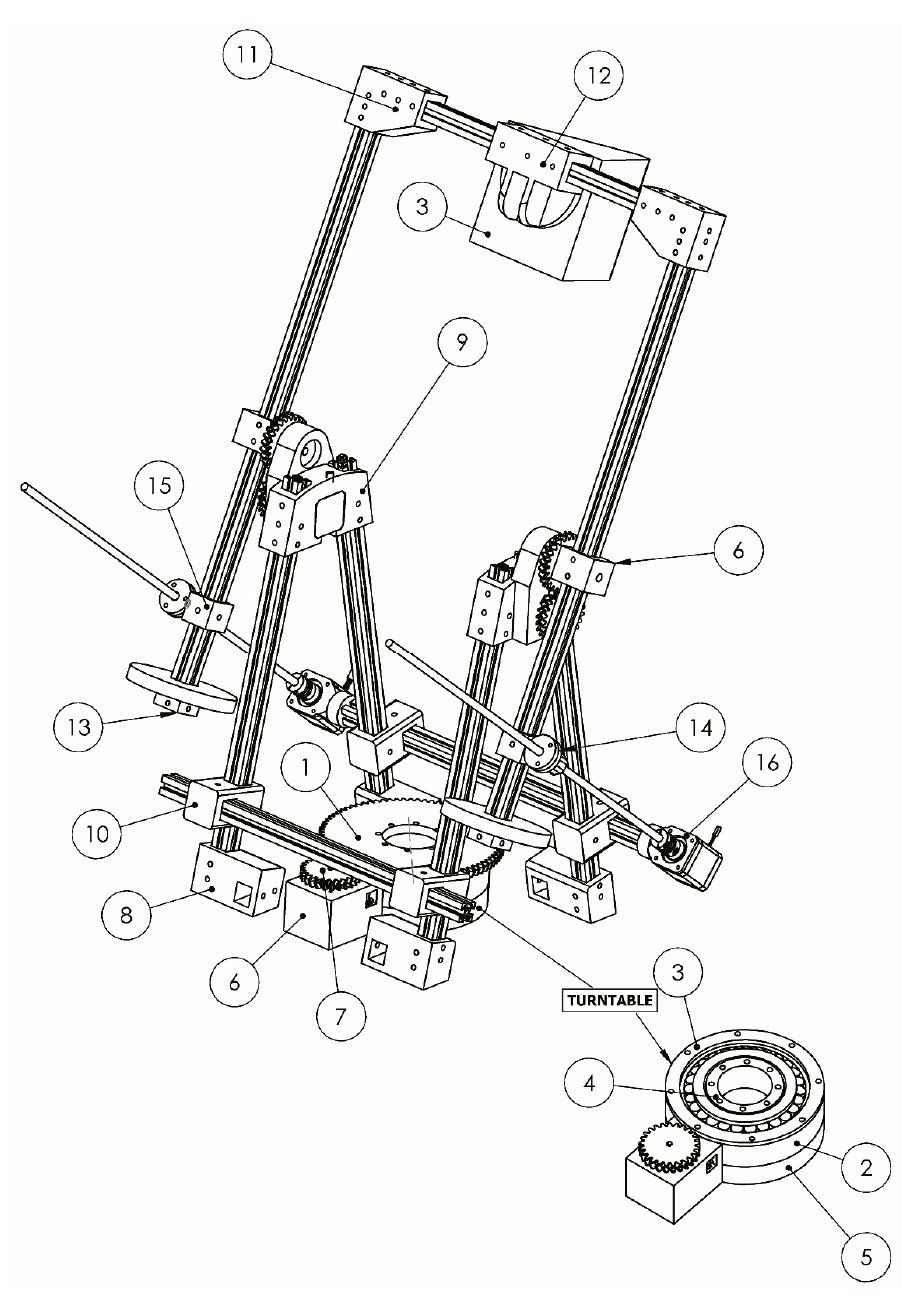
Figure 2. 3D Design Model. (Source: self-made).